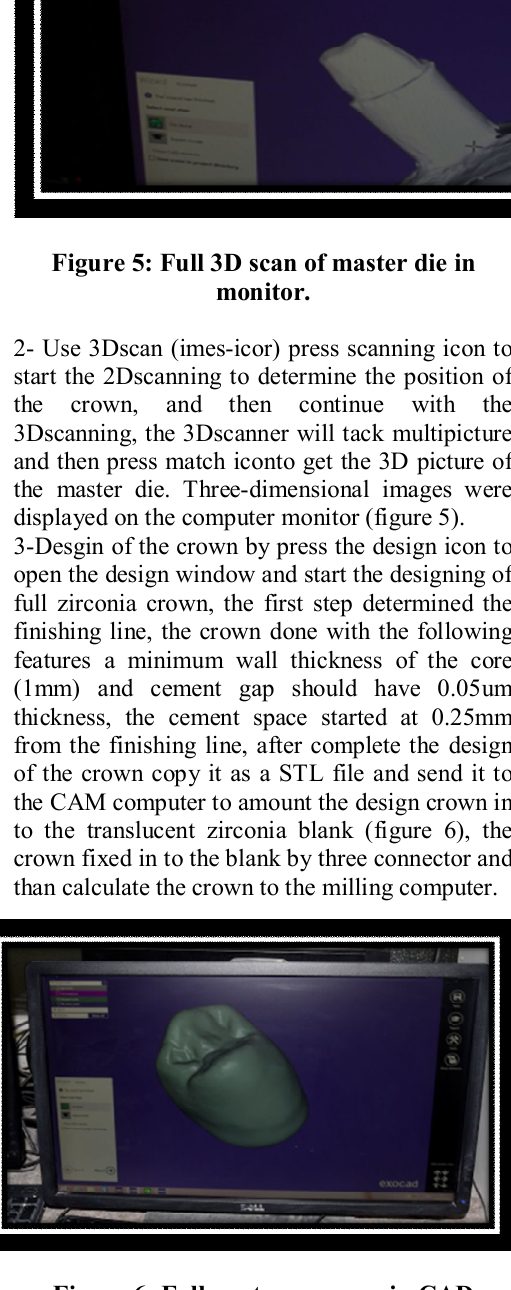
Figure 6: Full anatomy crown in CAD computer.